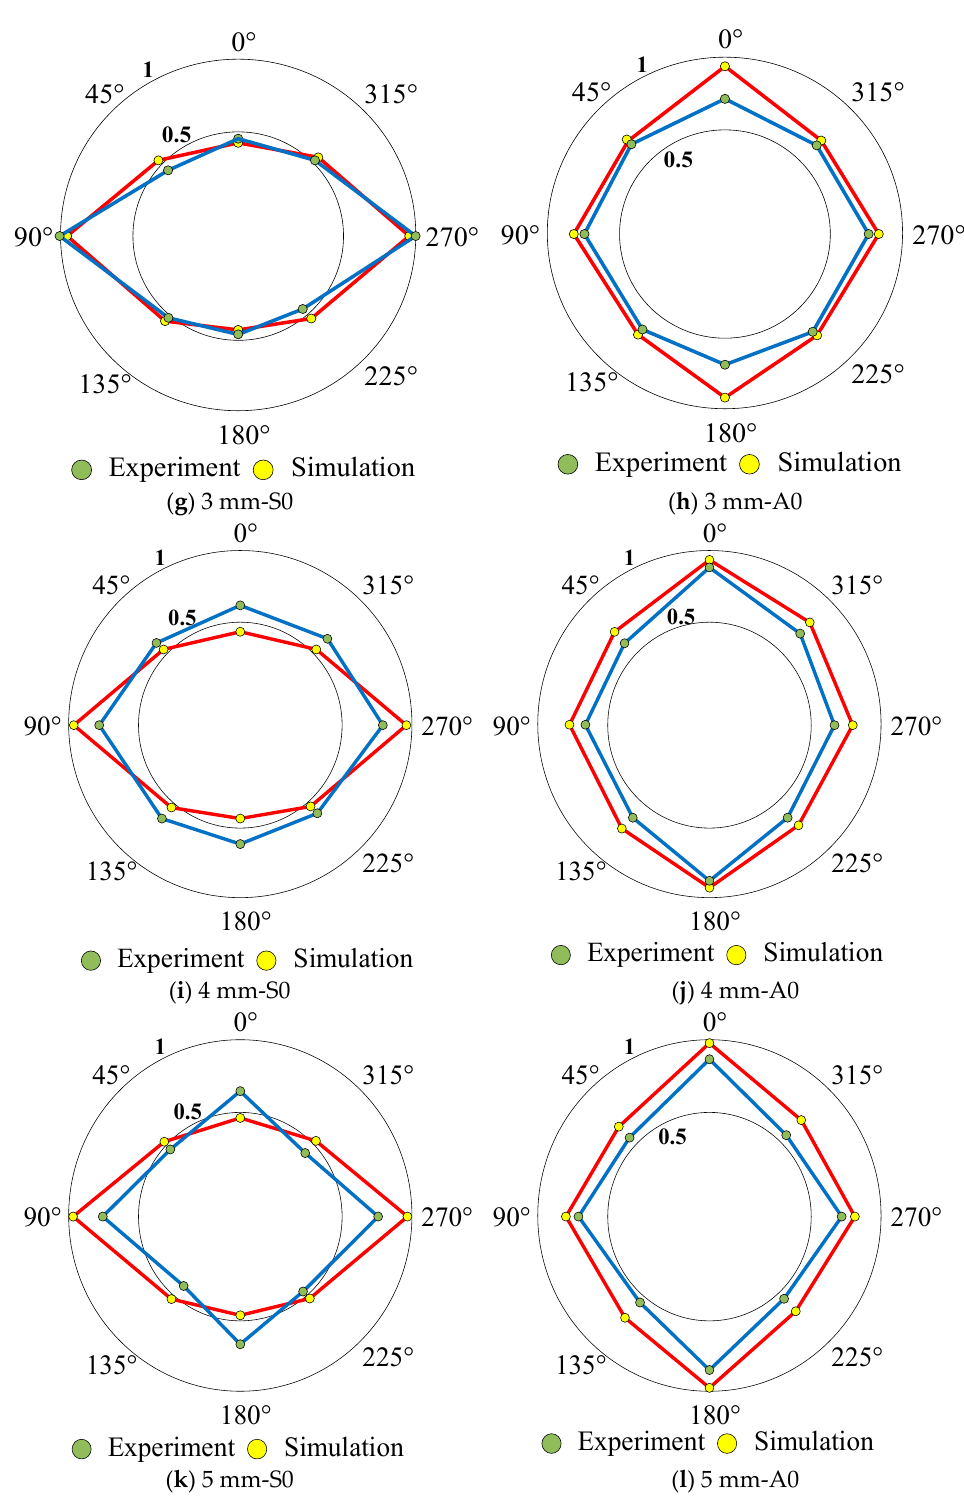
Figure 10. The directivity diagrams of curved plate under S0 and A0 modes.